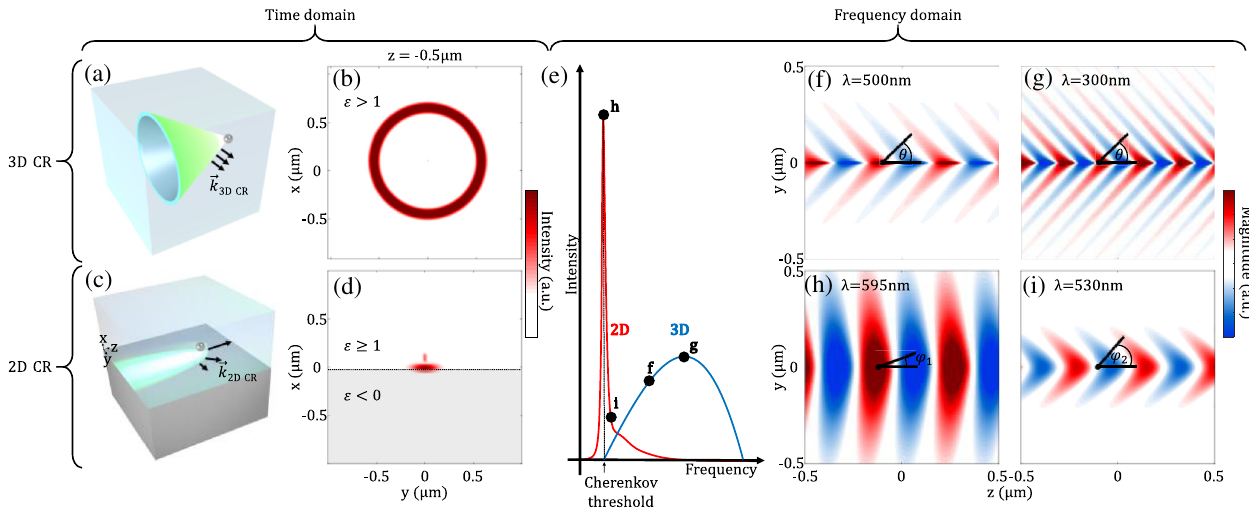
FIG. 1. 3D vs 2D CR: emphasizing their fundamentally different features. (a),(b) Illustration of 3D CR. The radiation is emitted in a set ⃗ k 3 of wave vectors ( ) which form a cone (a ring cross section) around the direction of electron velocity, with zero intensity at the DCR direction of motion. (c),(d) Illustration of 2D CR. The radiation is emitted in a set of wave vectors ( peak intensity at the electron ’ s direction of motion (shown in the cross section by the peak intensity near the surface). (e) Schematic comparison of 3D CR and 2D CR spectra. Since the dispersion of conventional materials is relatively small and isotropic, the 3D CR spectrum is broad and peaks at a frequency higher than the Cherenkov threshold. In contrast, the 2D CR spectrum is narrow, peaks at the Cherenkov threshold, and decays sharply for large frequencies. (f) – (i) Comparison between the electric field profiles in 3D CR and 2D CR for selected wavelengths brought as examples of the frequency dependence [corresponding to the points in (e)]. These panels highlight the dispersive emission angle of 2D CR versus the nondispersive emission angle of 3D CR. θ [in (f) and (d)] and φ 1 and φ 2 [in (h) and (f)] are the angles between the electron trajectory and the direction of electromagnetic wave emission,